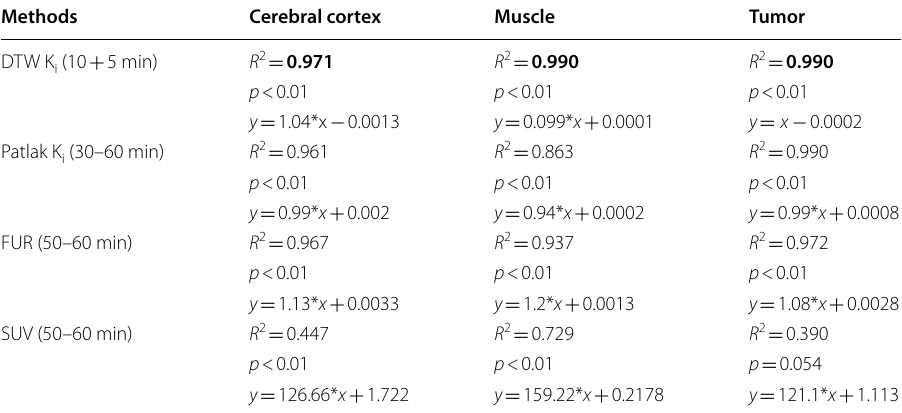
Table 2 Correlation analysis for K and its surrogate parameters from different quantification i methods; the squared correlation coefficient ( R 2 ), p value( p ), and linear regression equations with each quantification method were listed in the table and the results of strongest correlation was marked in